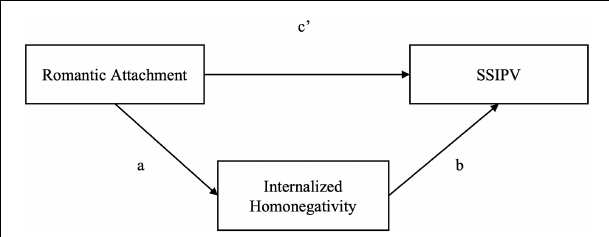
FIGURE 1 | Hypothetical model. Outcome: Perpetrated Same-Sex Intimate Partner Violence (CTS2S); Mediator: Internalized Homonegativity (MISS-L); Predictor: Anxiety and Avoidance dimensions of romantic attachment